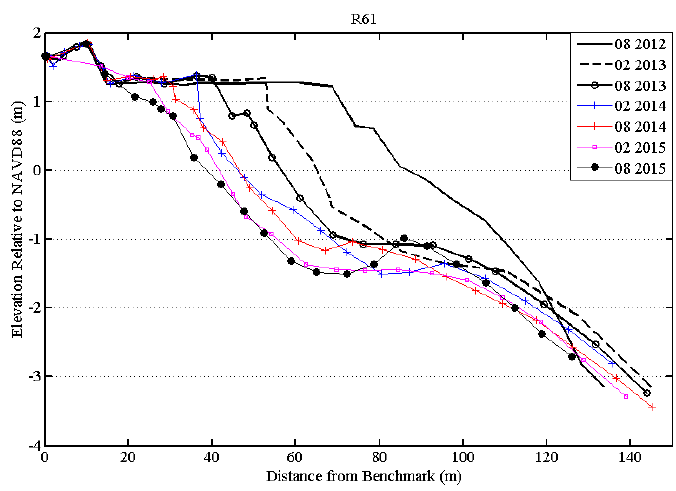
Figure 5. Example profile from the North Sand Key project area at R61.